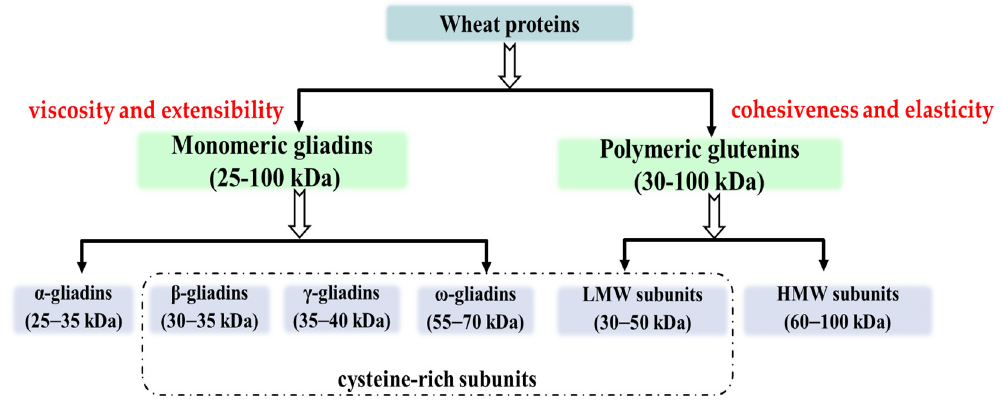
Figure 1. Classifications of wheat protein.